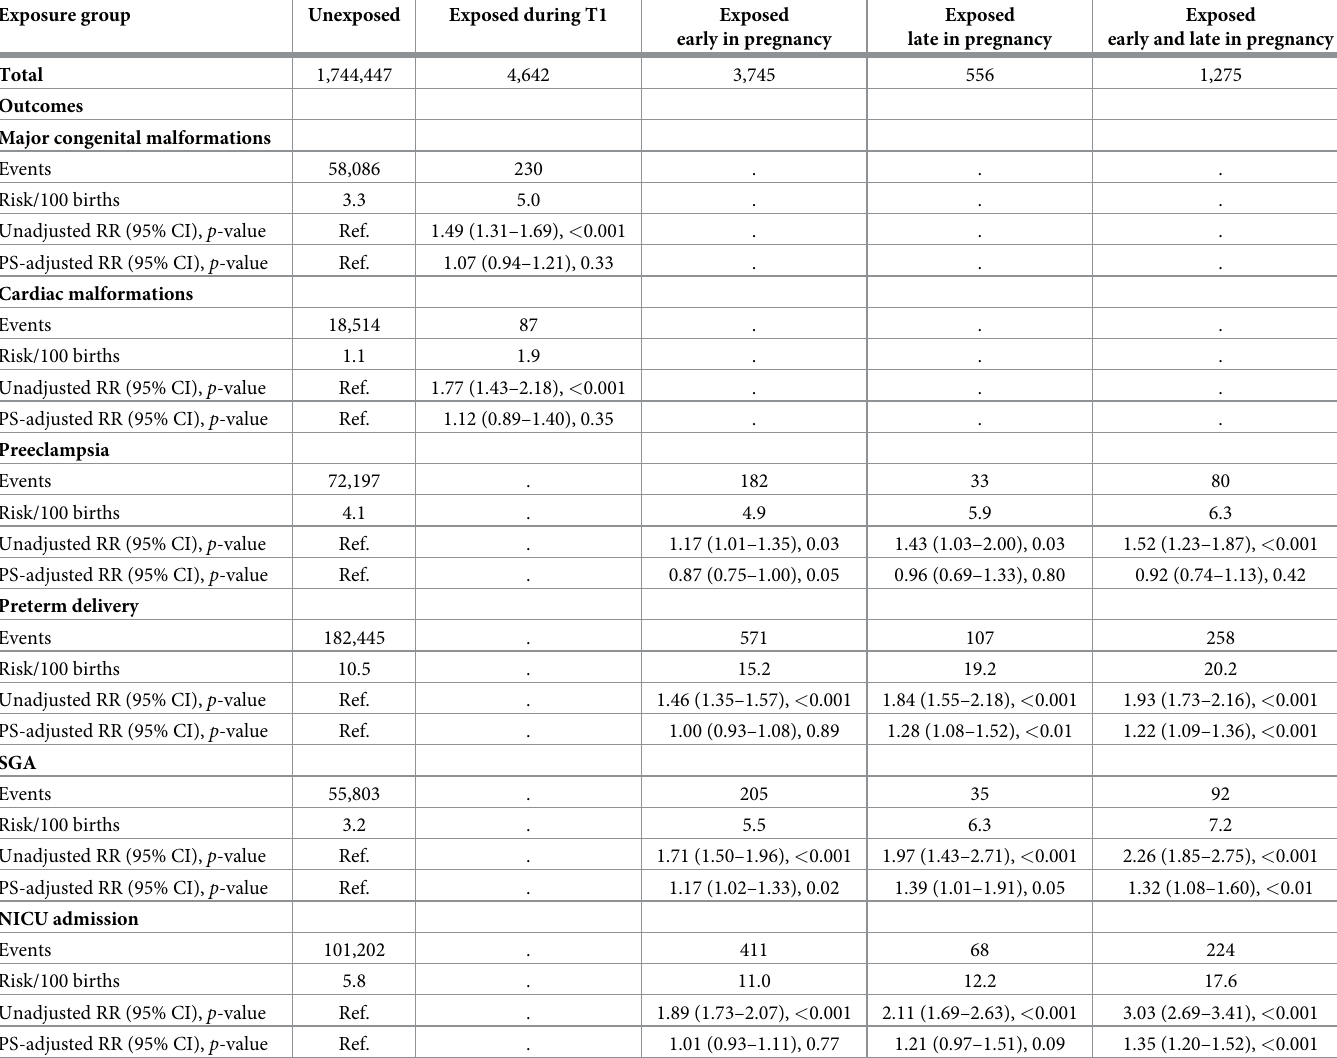
Table 2. Absolute and relative risk of neonatal and maternal outcomes associated with exposure to gabapentin compared with unexposed pregnancies. Exposure group